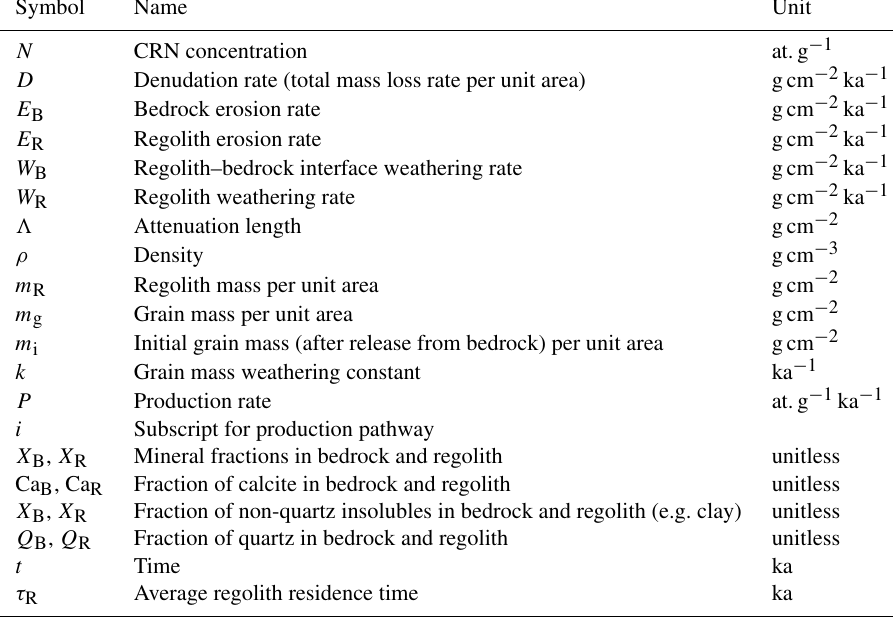
Table 1. Variable